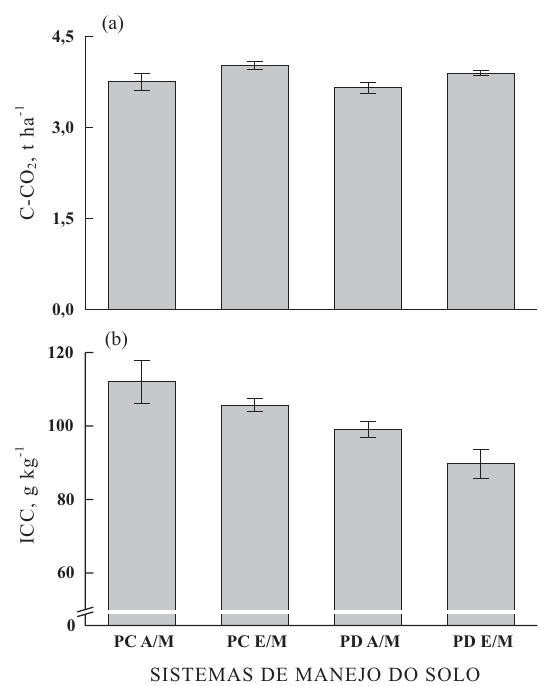
Figura 3. Emissão total de C-CO do solo no período 2 de 17 meses (a) e Índice de Conservação de Carbono-ICC (b), calculado pela razão entre a emissão total de C-CO e a quantidade de C nos 2 resíduos vegetais e na matéria orgânica no solo em um Argissolo Vermelho sob diferentes sistemas de preparo e de cultura. PC: preparo convencional, PD: plantio direto, A: aveia-preta, E: ervilhaca comum e M: milho. Barras verticais: erro-padrão da